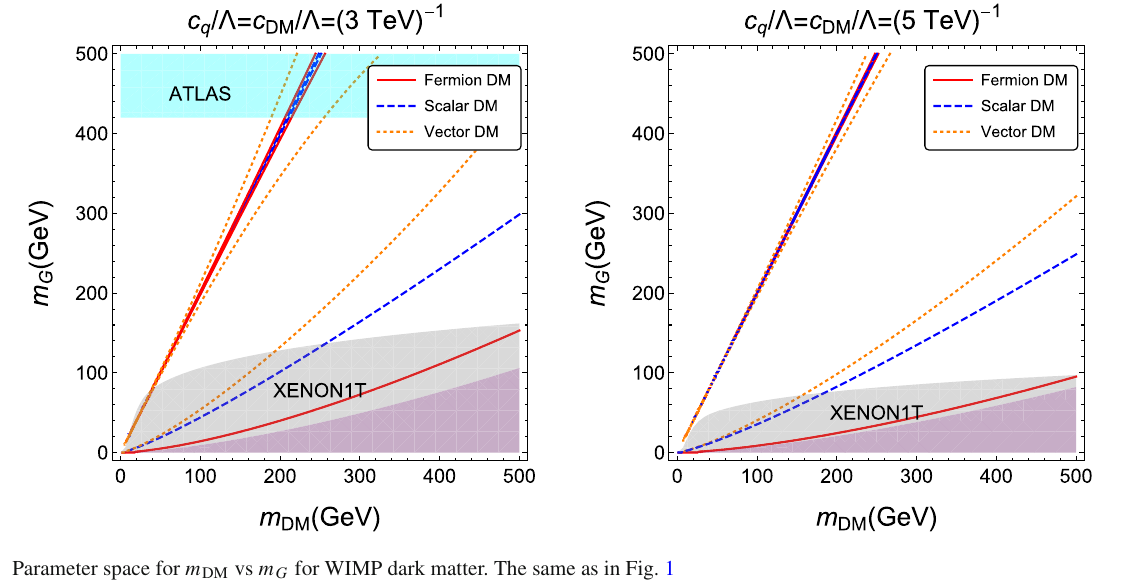
Fig. 2 Parameter space for m DM vs m G for WIMP dark matter. The same as in Fig. 1